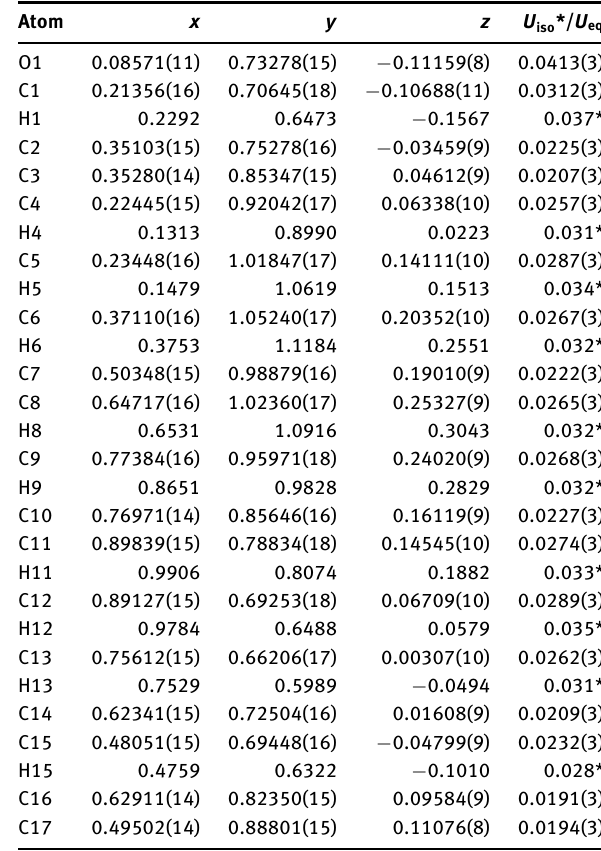
Table 2: Fractional atomic coordinates and isotropic or equivalent isotropic displacement parameters (Å 2